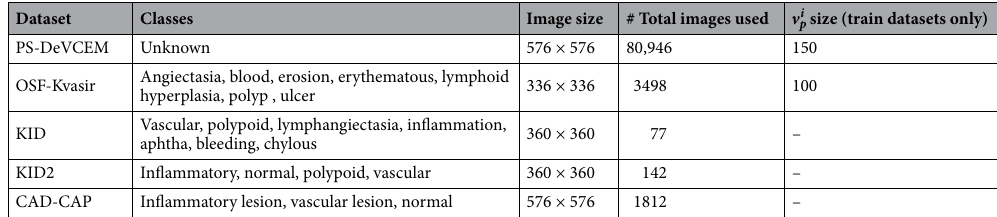
Table 1. Dataset details. Attribute v i p size indicates the initial crop size of v i p for each dataset. v i p is resized to 120 × 120 irrespective of the dataset before input to the